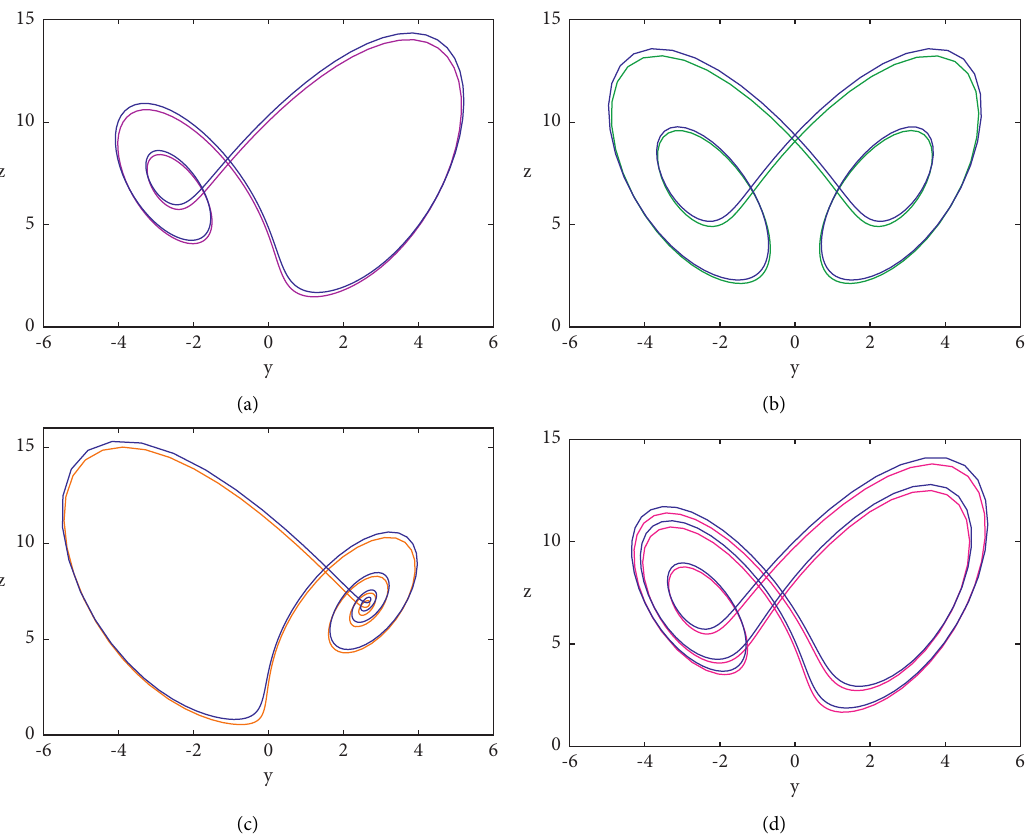
Figure 7: Four unstable cycles in the Rucklidge system for ( a,b ) � ( 2 , 6 . 7 ) : (a) cycle 001, (b) cycle 0011, (c) cycle 01111, and (d) cycle 00101. Blue curves represent the initial loop guess used for the